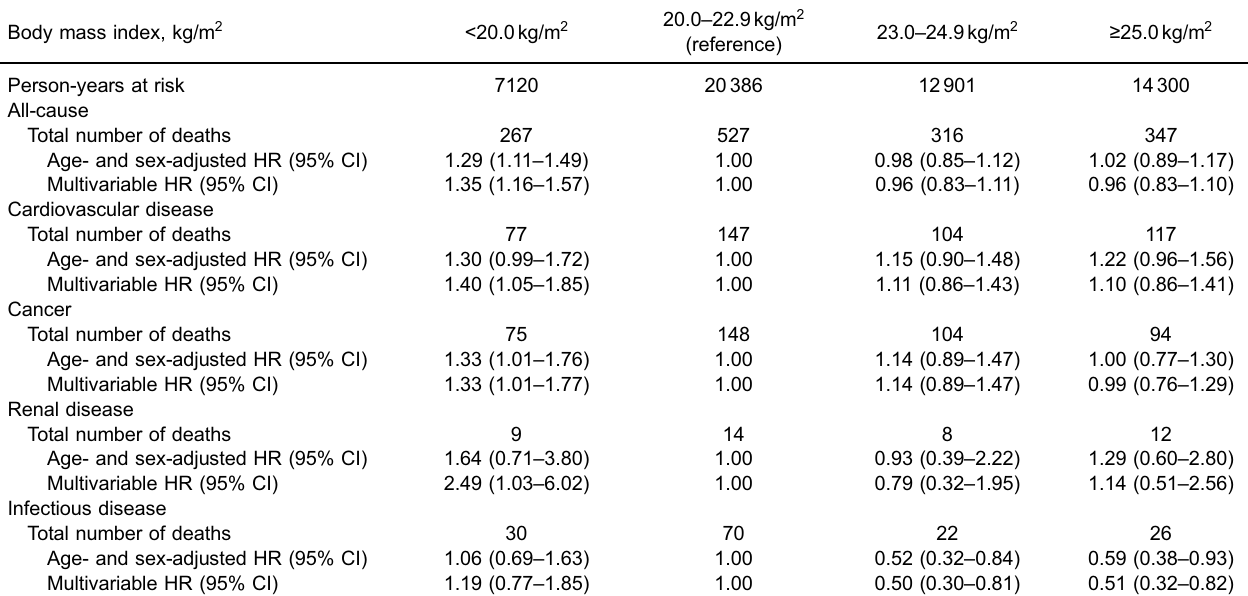
Table 2. Age- and sex-adjusted hazard ratios and multivariable a hazard ratios for cause-speci fi c mortality according to body mass